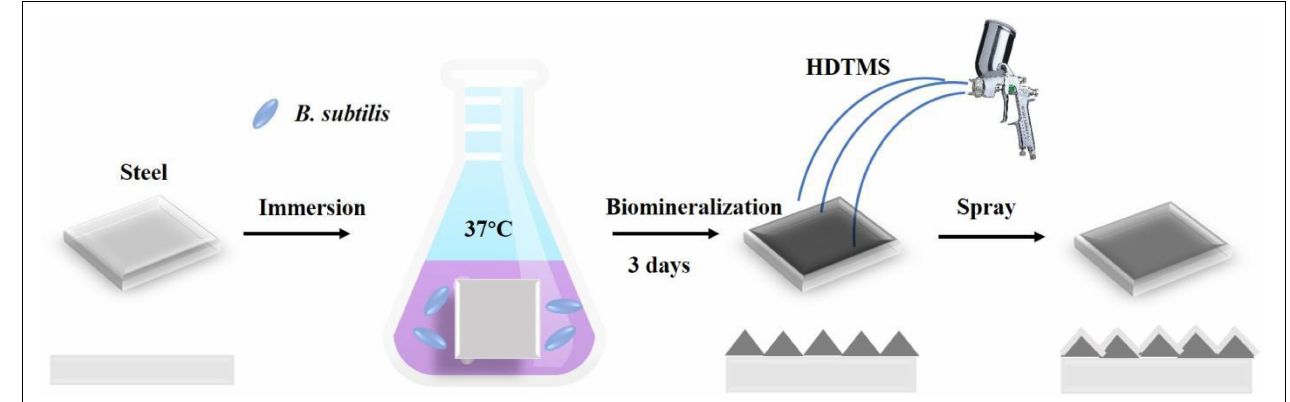
FIGURE 1 | Schematic of fabrication process for the superhydrophobic hexadecyltrimethoxysilane (HDTMS)/calcite